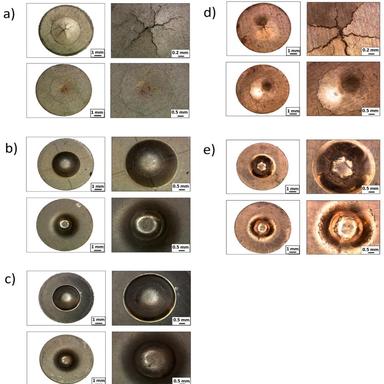
Deformed and fractured specimen a) as-sprayed steel (ASS-2) b) annealed steel (ANS-1) c) HIPed steel (HIPS-1) d) as-sprayed copper (ASC-1) e) annealed copper (ANC-2).